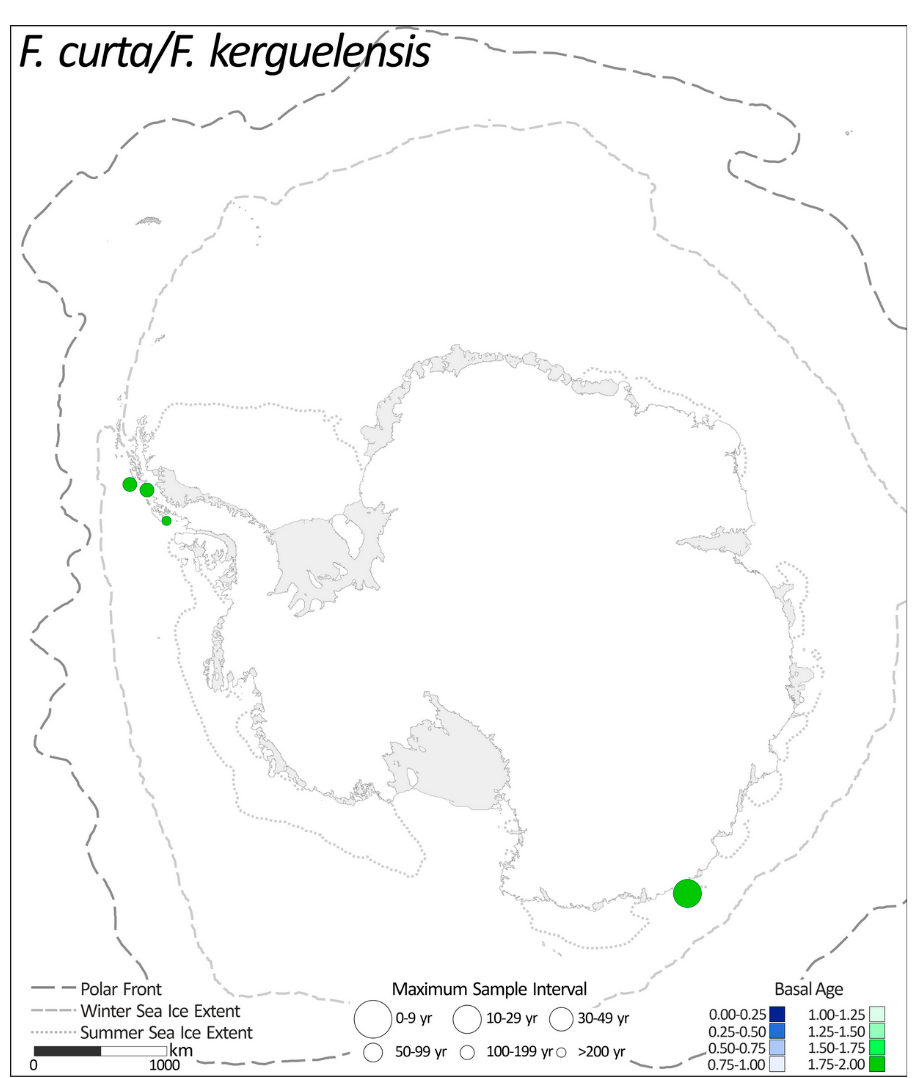
Figure 5. Map showing cores sites where F. curta/F. kerguelensis is used to reconstruct sea ice conditions. The symbol size reflects the resolution of the record and the color of the symbol indicates the basal age of the record between 0 and 2 ka BP.